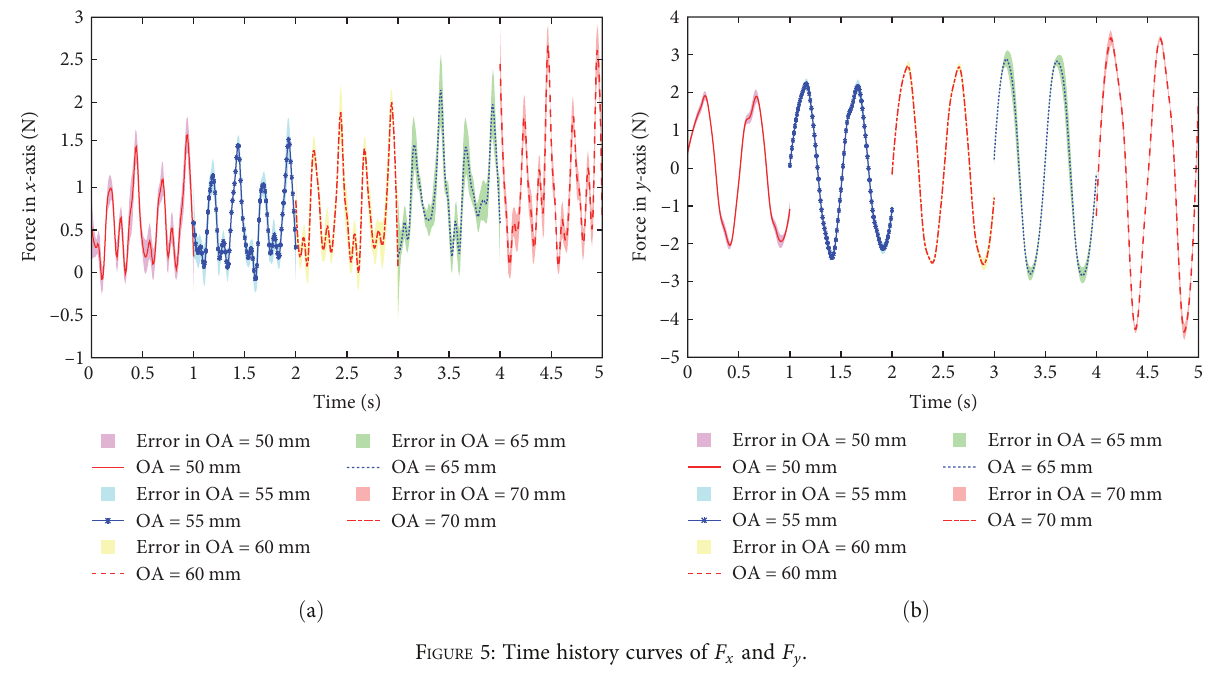
F IGURE 5: Time history curves of F x and F y